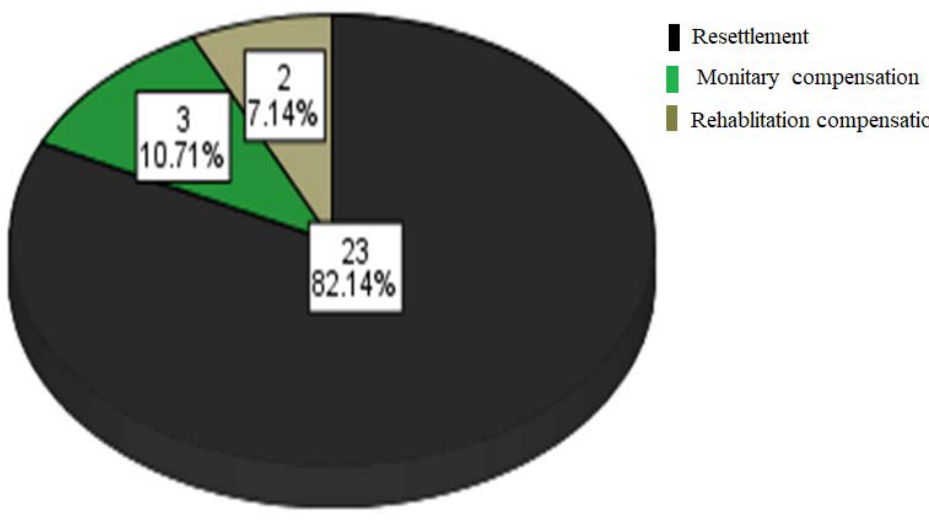
Figure 5. Enhancement and mitigation measures in settlement areas.